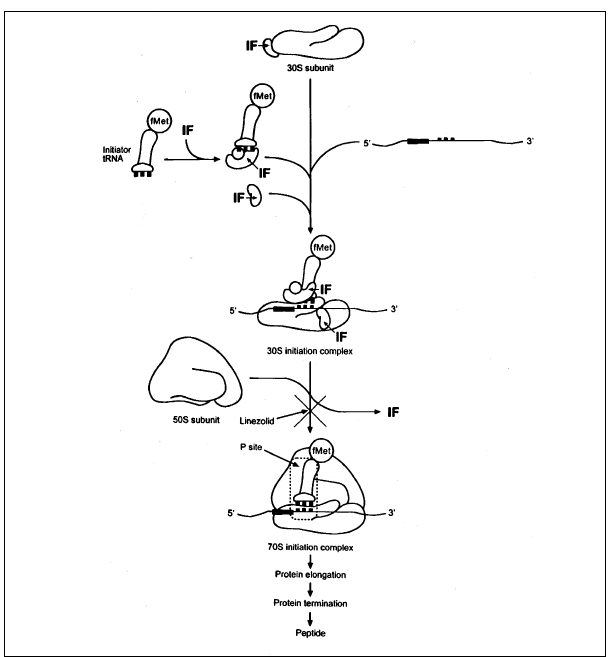
Figure 3) Mechanism of action of oxazolidinones: Inhibition of the protein synthesis initiation